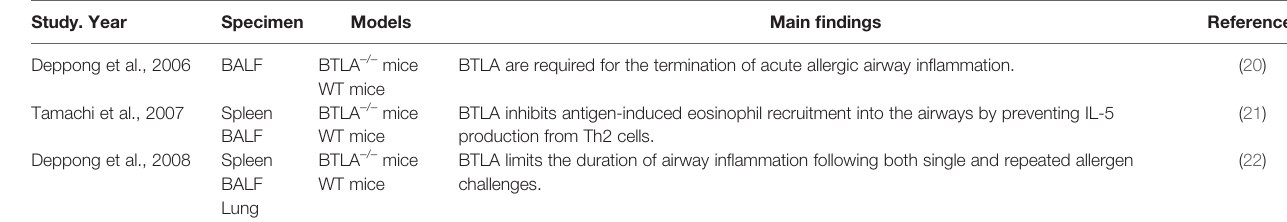
TABLE 1 | The function of BTLA in acute allergic airway in fl